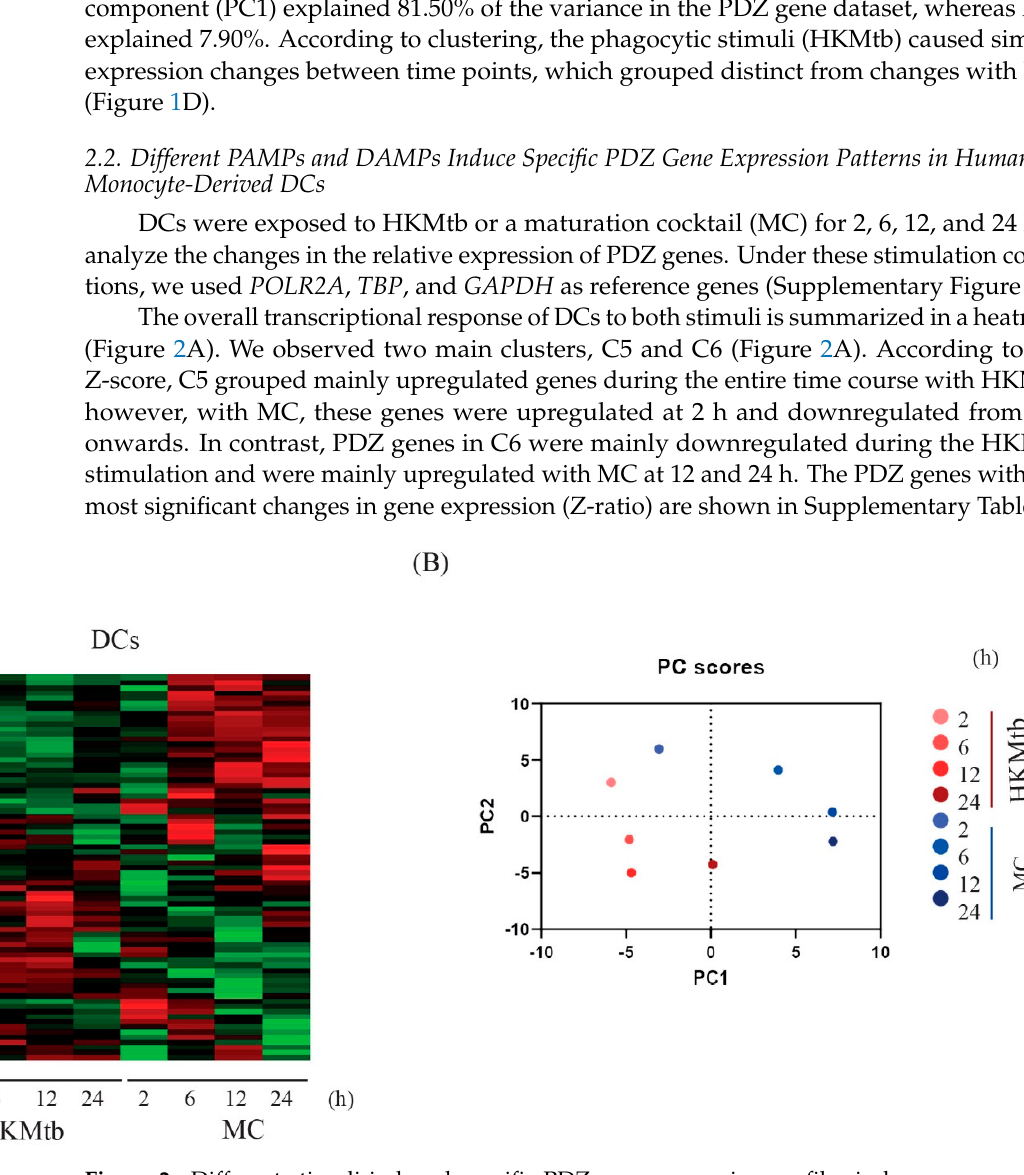
Figure 2. Different stimuli induced specific PDZ gene expression profiles in human monocyte-derived DCs. A total of 75 of the 83 gene panels were found to be expressed in DCs at baseline, eight genes were not expressed under basal conditions ( CARD10, CARD14, DLG2, MAGI1, MAGI2, MPP4, PDZRN4, CNKSR1 ). ( A ) Heatmap showing hierarchical clustering of the PDZ gene expression profile changes of DCs at 2, 6, 12, and 24 h post–stimulation with HKMtb and MC, referenced to unstimulated DCs. Data are presented as Z–score, corresponding to the change of expression of each time point respect to the media of changes during the entire time course, where negative Z–score indicates a decrease (red), and positive Z–score indicates an increase (green) of each PDZ gene. ( B ) PCA analysis of qPCR data from DCs stimulated for 2, 6, 12, and 24 h with HKMtb or MC.